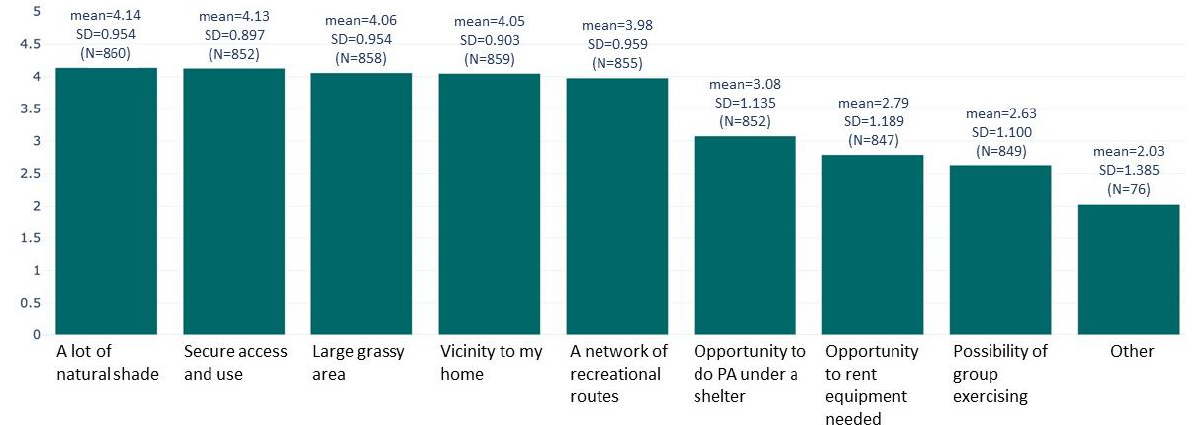
Figure 5. Features of Green Spaces, Important to Respondents for their Physical Activity. Note: Missing values are excluded from the calculation.